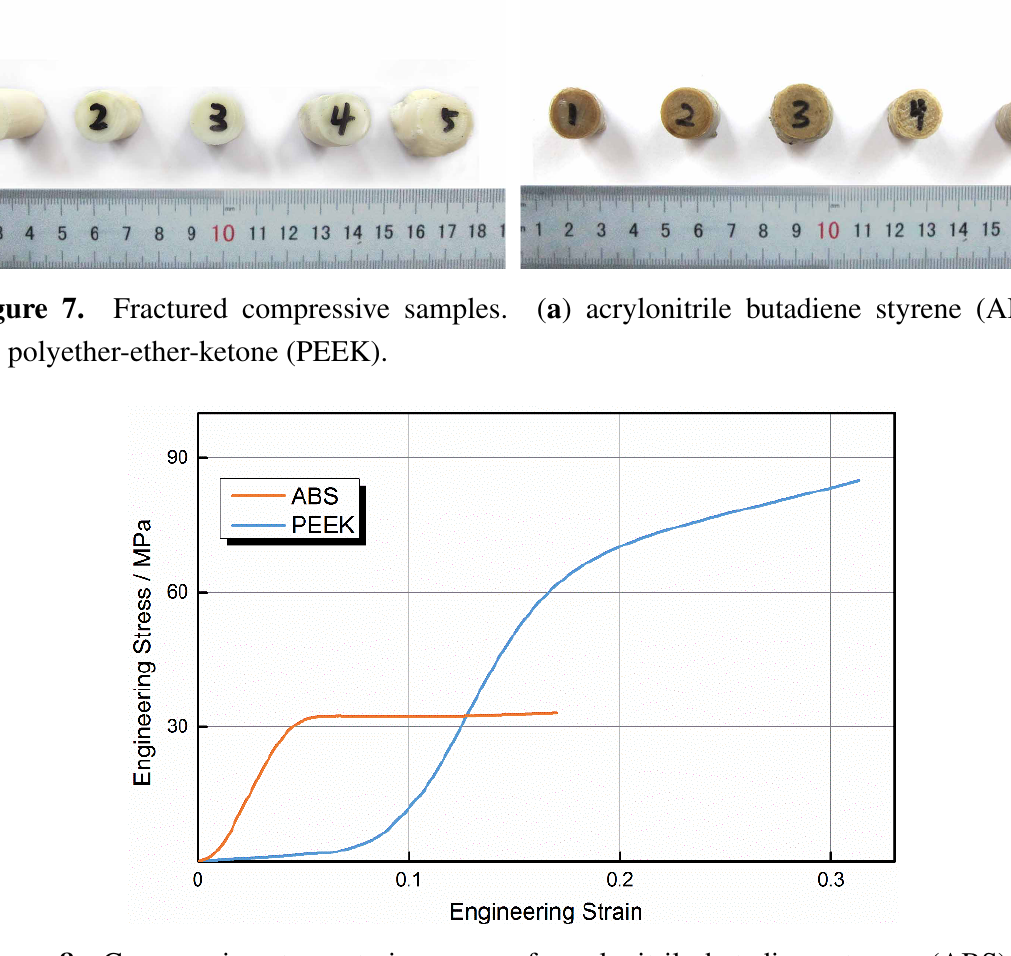
Figure 8. Compressive stress-strain curves of acrylonitrile butadiene styrene (ABS) and polyether-ether-ketone (PEEK).